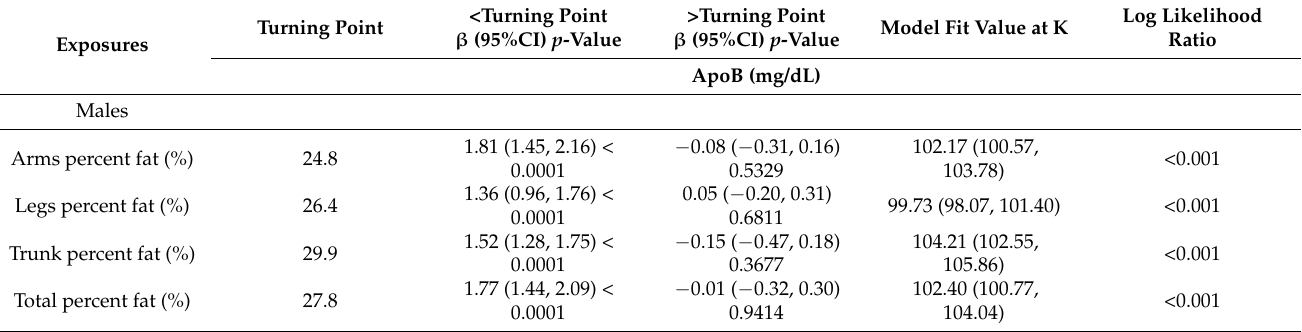
Table 3. Threshold analysis of ApoB and specific fat depot features. Age, race, hypertension, diabetes, hyperlipidemia, coronary heart diseases, vigorous work activity and smoking status were